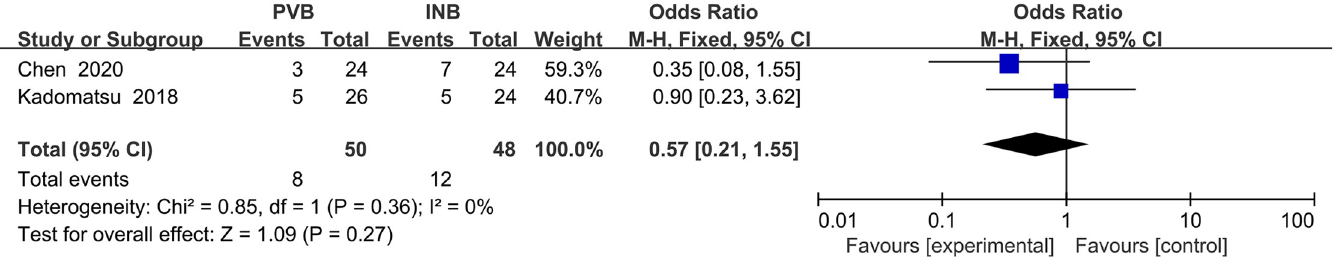
PLOS ONE | https://doi.org/10.1371/journal.pone.0237363 October 5,